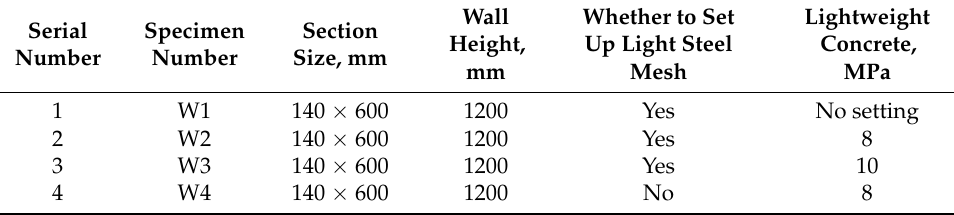
Figure 1. Size design drawing of LSKLCW. ( a ) Front size; ( b ) Cross-section size. Table 1. Parameters of LSKLCW